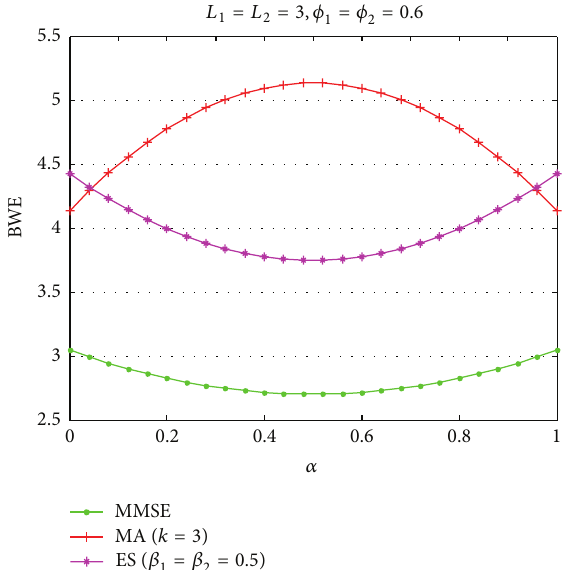
Figure 17: Comparison of three different forecasting methods by varying 𝛼 ( 𝑘 = 19